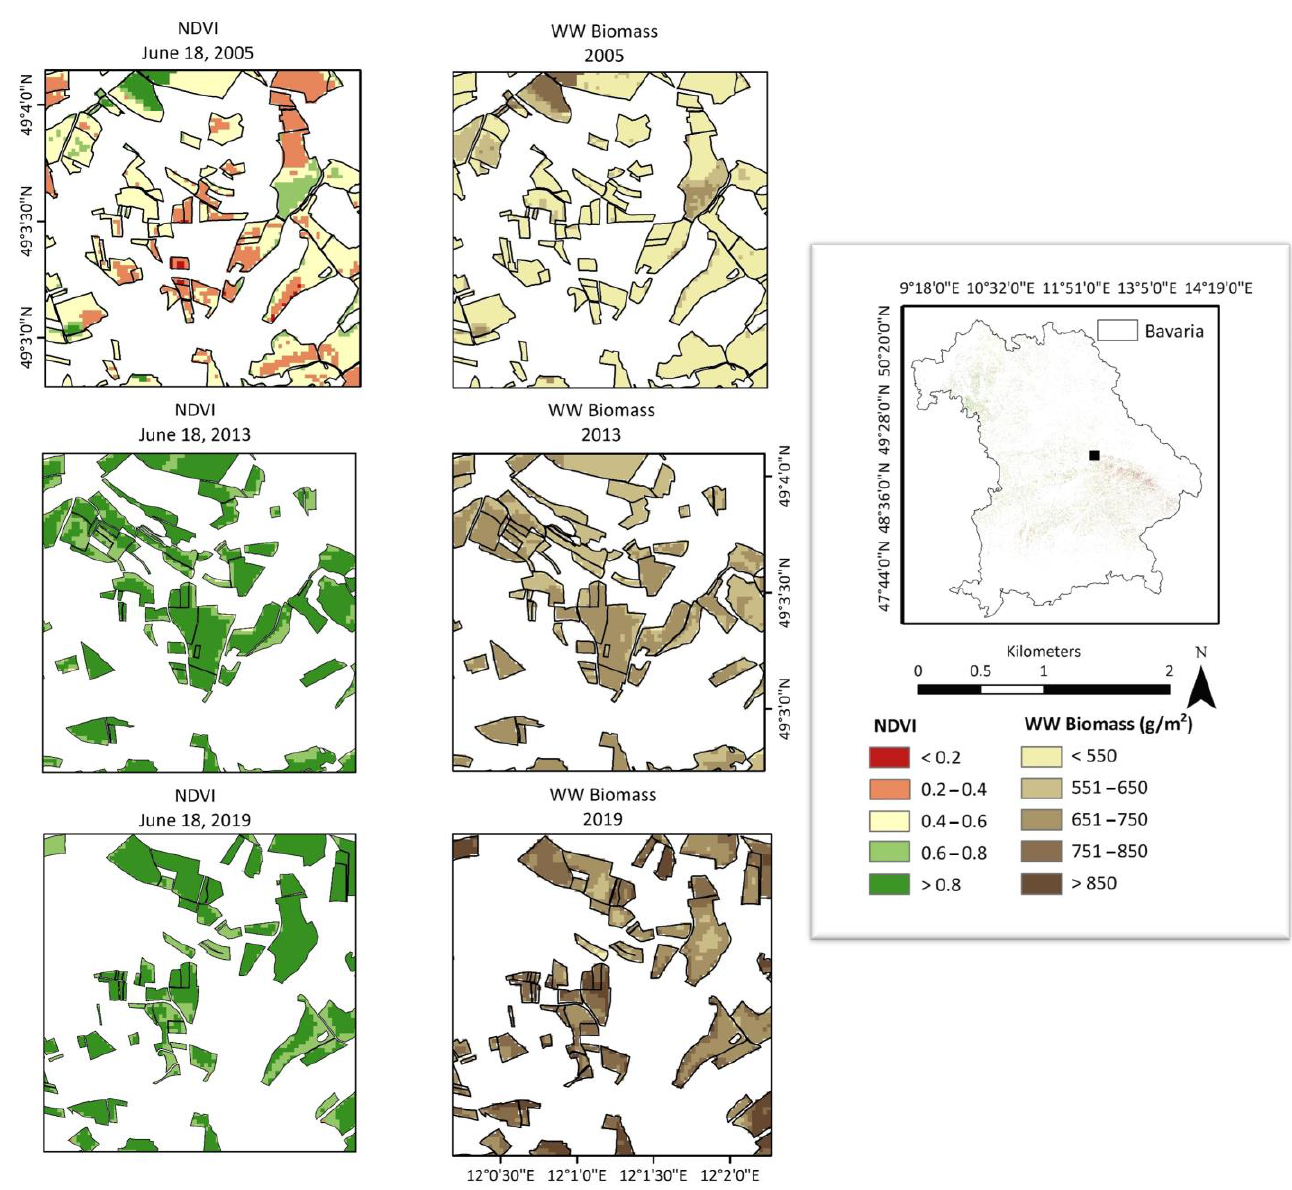
Figure 16. The side-by-side visualisation of synthetic NDVI products obtained on 18 June 2005, 2013 and 2019 ( left ) with the WW biomass obtained from the LUE modelled for the years of 2005, 2013 and 2019 ( right ).